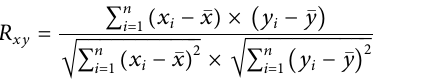
Frontiers in Environmental Science |